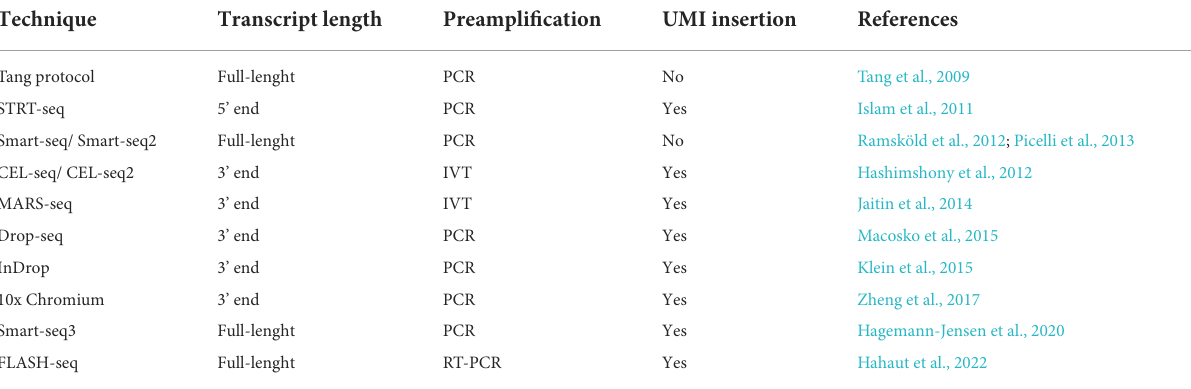
TABLE 1 Summary table of the most common single-cell sequencing techniques explored in this section, “Single-cell RNA sequencing”.